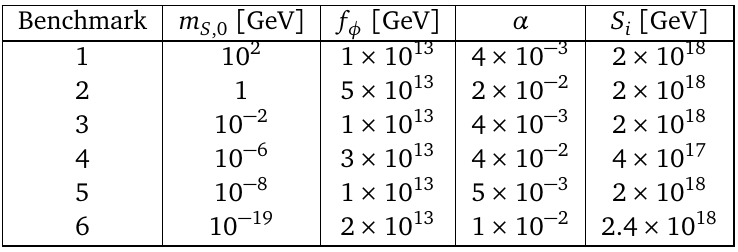
Table 1: Parameter values of the benchmark spectra depicted in Fig. 5.